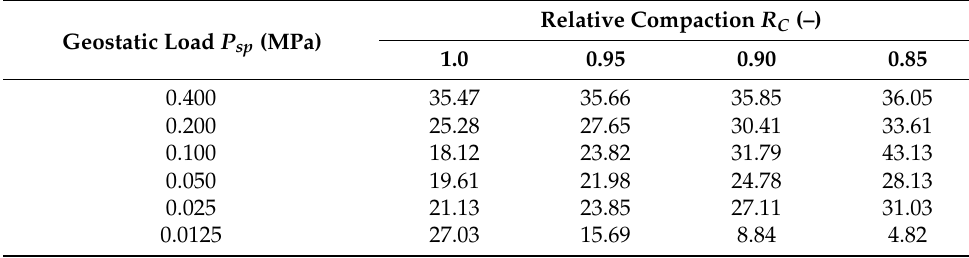
Table A5. Secant Constrained Blast Furnace Slag (BFS) Modulus, E ode